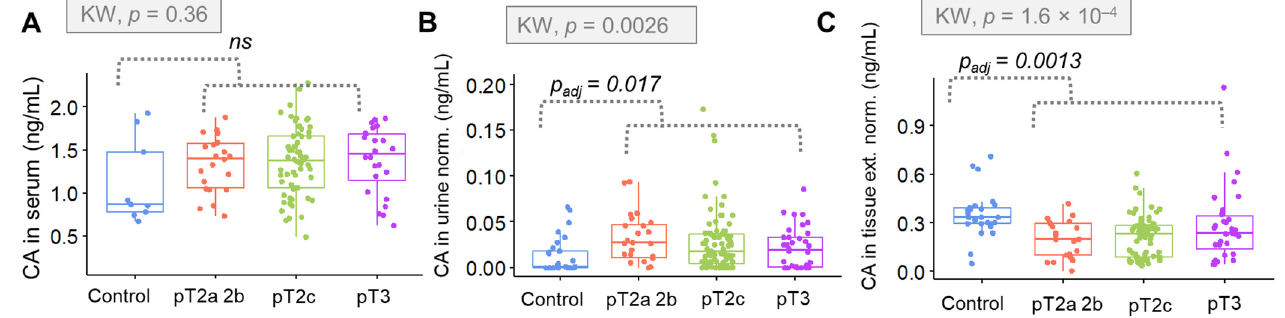
Figure 5. HCA associated with a heatmap; The condition code refers to different PCa stages accord ‐ ing to GS. CA = citric acid, LDL = low density lipoprotein, TC = total cholesterol and HDL = high density lipoprotein.